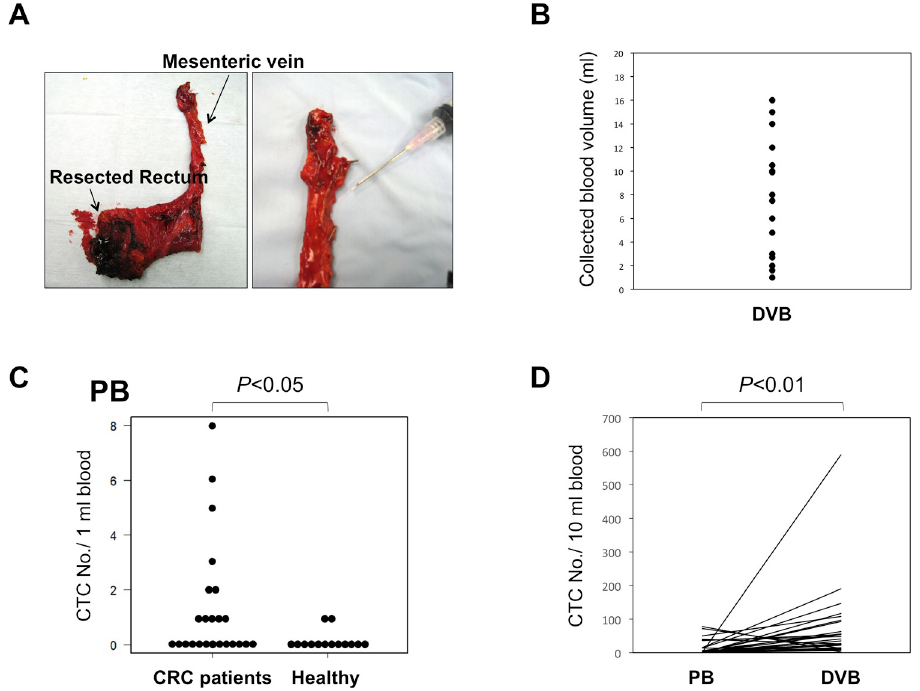
Fig 5. Collection of DVB and numbers of CTCs in DVB and PB from CRC patients. (A) DVB was obtained by puncture of the main trunk of the mesenteric vein of the resected colon. Enlarged view of mesenteric vein (right). (B) Variations in DVB volumes collected. (C) Numbers of CTCs in PB from CRC patients (n = 26) and healthy volunteers (n = 14). p < 0.05. (D) Numbers of CTCs in PB and DVB from individual CRC patients (n = 26). p <